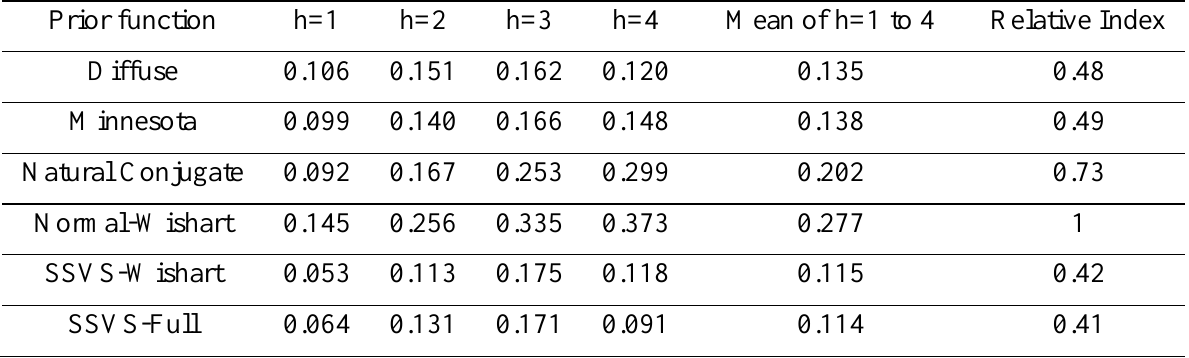
Table 3. RMSE index prediction of model (GS, E-RE, CO2)